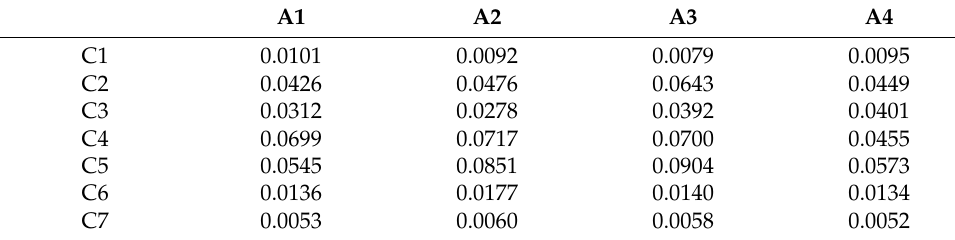
Table 6. The weighted normalized decision matrix for selecting a third-party logistics provider.